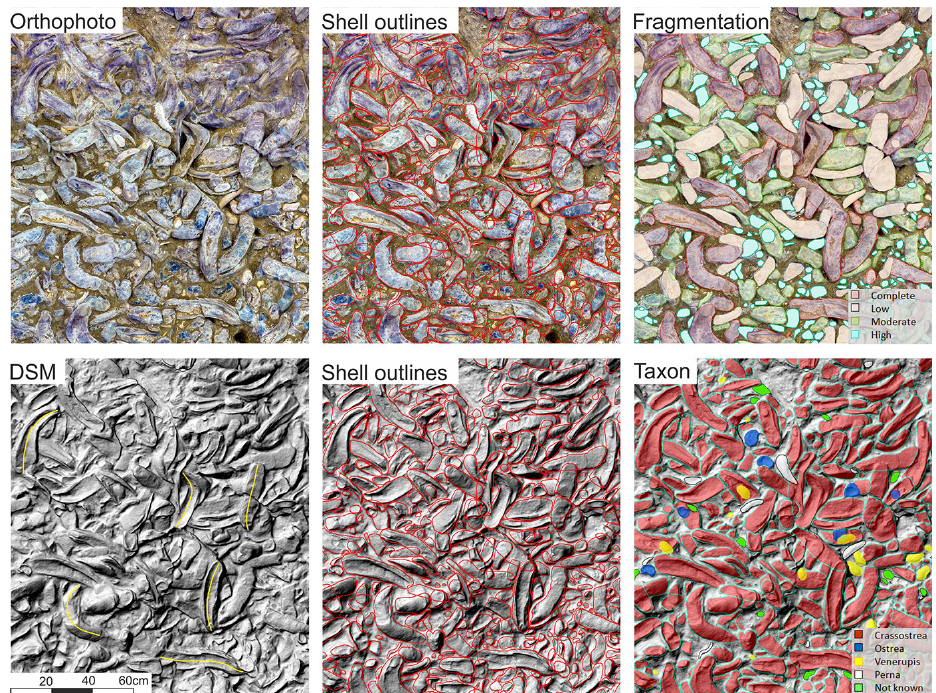
Figure 3. Examples of the data acquisition: orthophoto and digital surface model (DSM) are used to define shell outlines manually. Together with various attributes, such as degree of fragmentation and taxon ID, these data are georeferenced in an ArcGIS database. Yellow lines in the DSM are examples of center